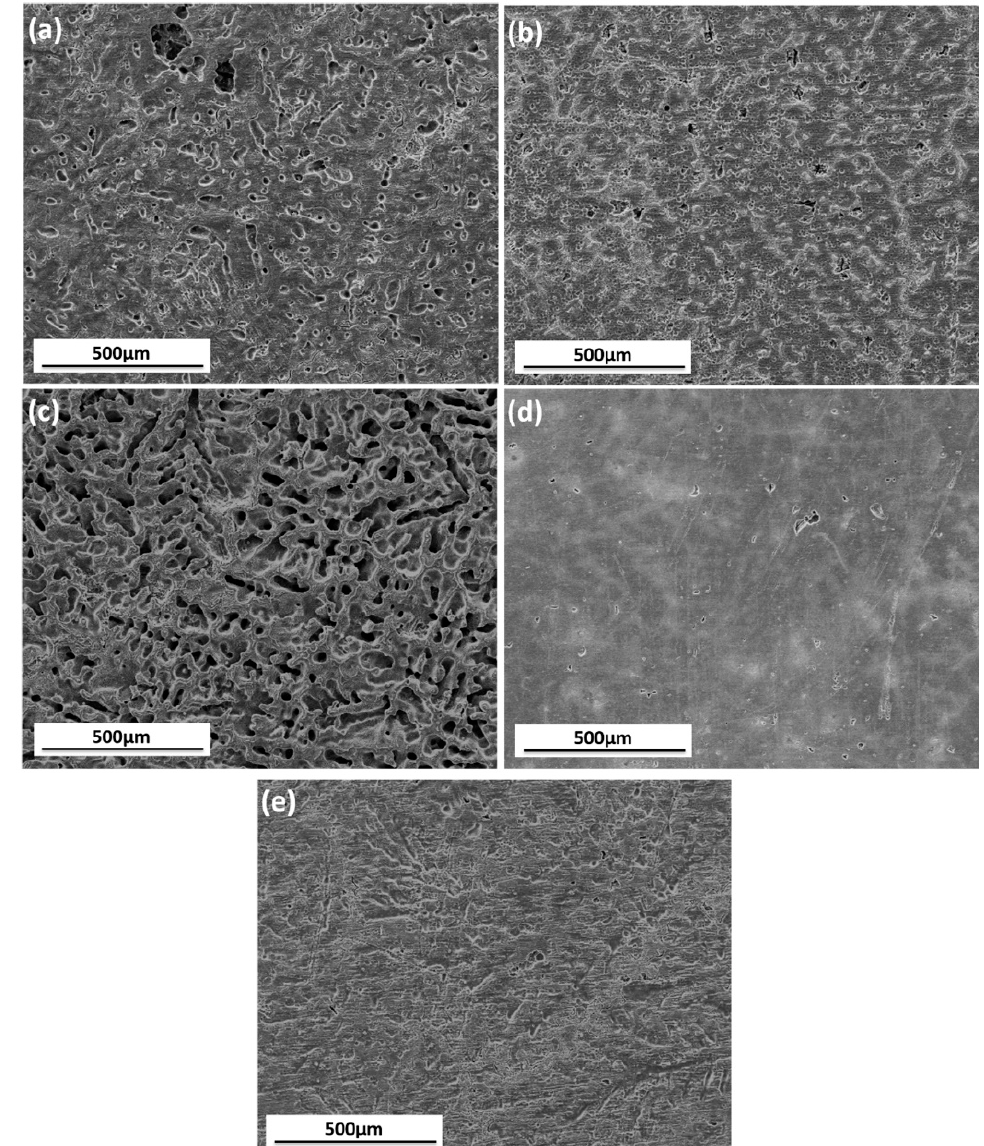
Figure 11. SEM images of AZ91D immersed in simulated HA solution ( a ), and solutions at the of SO 2 − ( b ), NO − ( c ), NH + ( d ), Cl − ( e ) for 11 days after rust 3 4 4 shortage of SO 2- ( b ), NO - ( c ), NH + ( d ), Cl − ( e ) for 11 days after rust removal. 4 3 4